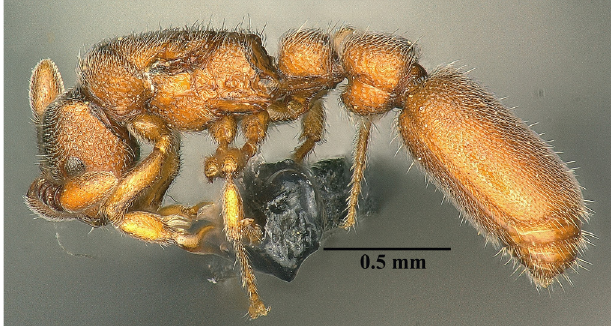
Fig 7 . Ooceraea octoantenna Zhou & Chen sp. nov., paratype queen, body in profile view.